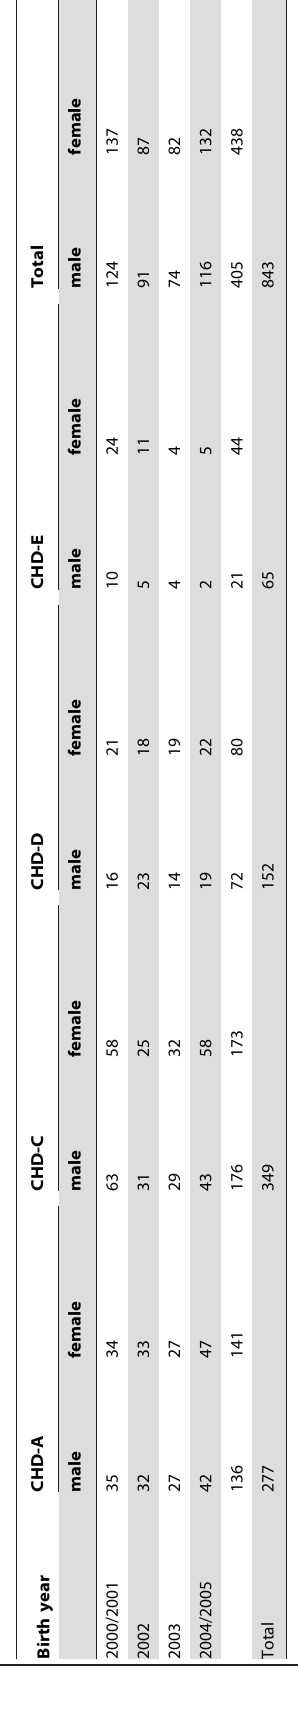
Figure S1 Q-Q-plot of expected –log 10 P-values versus observed–log 10 P-values from the mixed linear model analysis for canine hip dysplasia score in German Shepherd Dogs. Shown are all 47,729 SNPs included in the genome-wide association analysis with the grey line corresponding to the null hypothesis of no association. (DOC) Table S1 Results of the genome-wide association study for canine hip dysplasia in 192 German Shepherd Dogs. Given are the SNP-IDs with their locations on the dog chromosome according to CanFam2.0, the minor allele frequencies (MAF) in the sample and –log 10 P-values (P-MLM) from the mixed linear model analysis. The SNP BICF2S2367279 exceeds the threshold (5.98) for genome-wide significance. (DOC) Table S2 Single nucleotide polymorphisms (SNPs) with their chromosomal positions on CanFam2.0, adjacent genes, SBE primers, SBE orientations and SNP motifs genotyped in the validation set including 843 German Shepherd Dogs. Table S3 Comparison of -log 10 P-values using a cumulative logit and a linear model for an association analysis of canine hip dysplasia genotyped in the detection sample including 192 German Shepherd Dogs considering 96 CHD-A dogs as controls and 65 mildly, 22 moderately and 9 severely CHD-affected dogs. Shown are the raw -log 10 P-values of the five highest CHD- associated SNPs for a model with genotype as the sole effect and